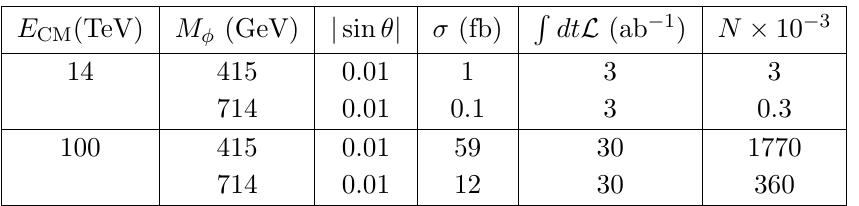
Table 4 . Comparison of the LHC and 100 TeV pp sensitivities to (cid:30) 0 production via the gluon fusion process, rescaling the cross sections given in refs. [52, 54, 60] by the minimum j sin (cid:18) j of eq. (4.12) for representative choices of M (cid:30)